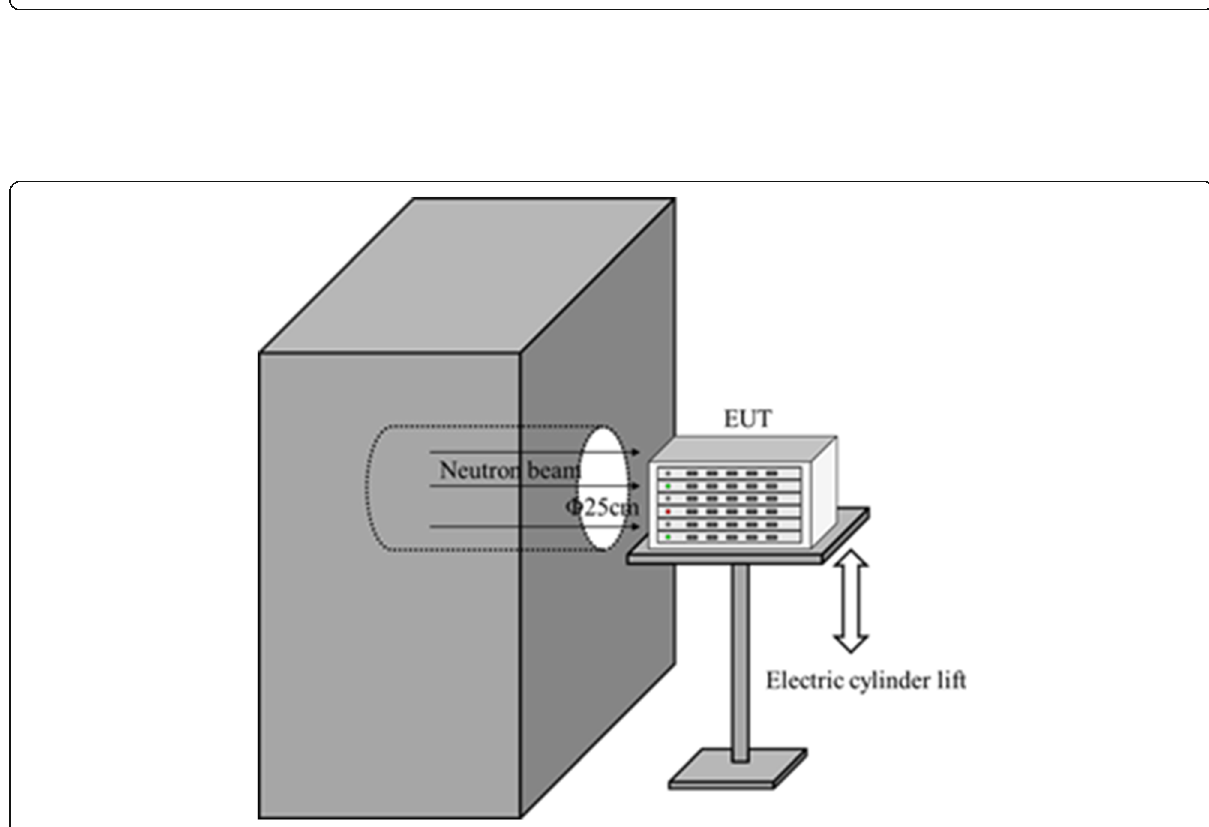
Fig. 16 Schematic view of the experimental setup